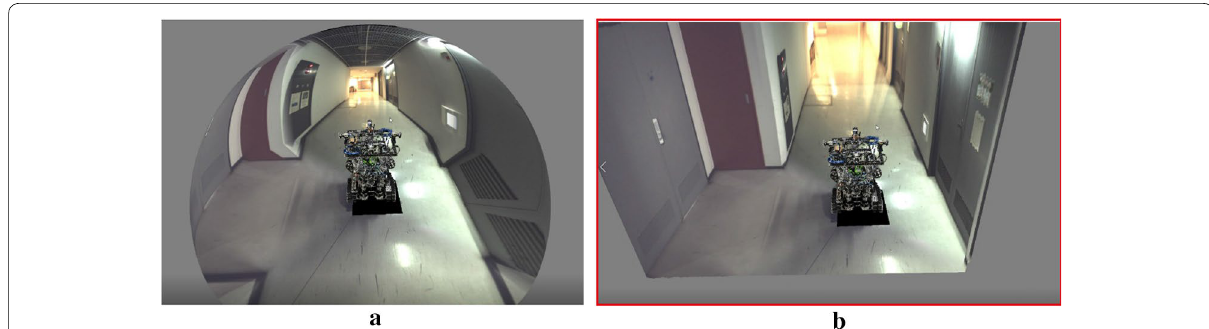
Fig. 12 Free viewpoint image generation in a corridor. a Generated by the previous method [7]. b Generated by the proposed method. The previous method generated distorted free viewpoint images, which makes it more difficult for operators to perceive the distance between the robot and the walls. On the other hand, the distance between the robot and the walls is obvious in images generated by the proposed